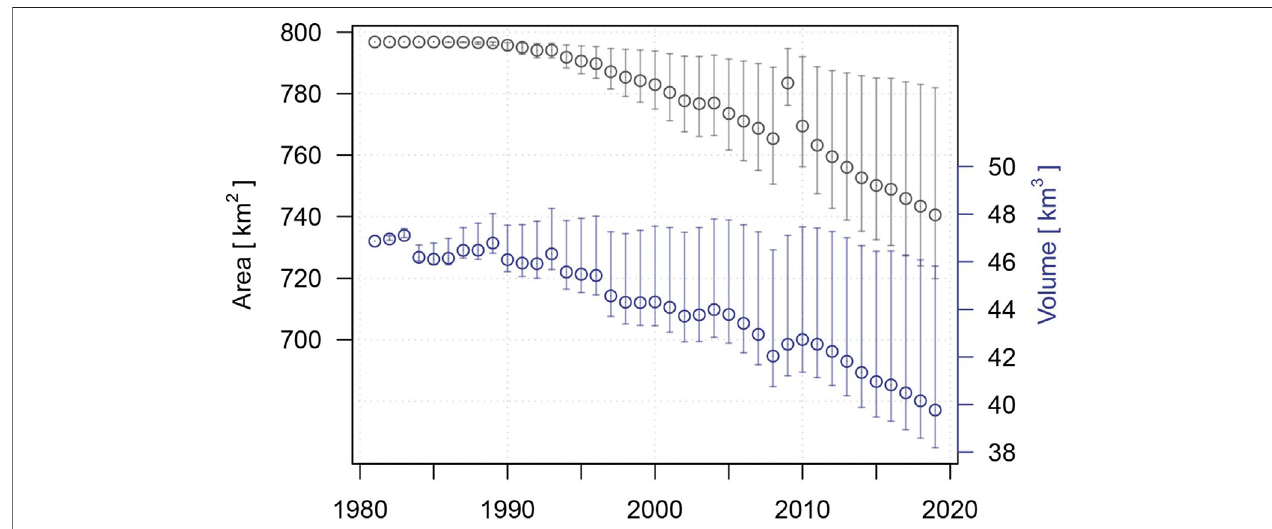
FIGURE 4 | Modelled glacier volume and area change for the study area. Besides the glacier ice, the model includes into glacier area also snow, if it does not melt during theablation season(turns into fi rn) oftheconsecutiveyear and if itoccupiestheformerlyglaciated area. Uncertainty wascalculatedfrom two additional scenarios using different reference geodetic mass balances according to the upper and lower uncertainty estimates by Barandun et al. (2021). The strong increase of the glacier area in 2009, is caused by the frequent summer snowfall not melting as it is considered as fi rn in the